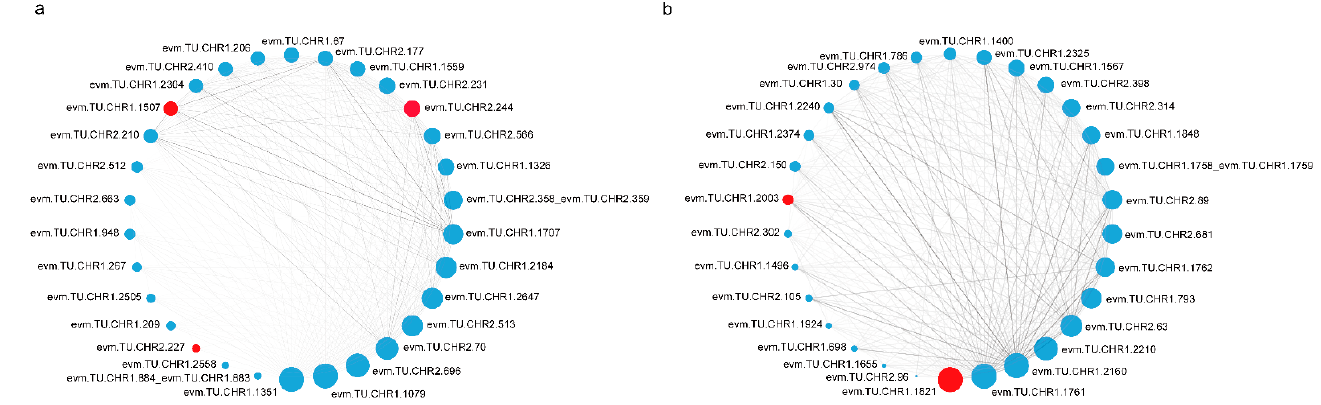
Figure 8. Co-expression regulatory network analysis of the black and blue module. Co-expression regulatory network analysis of the black and blue module. ( a ) Co-expression network constructed by 30 hub genes in black modules; ( b ) Co-expression network constructed by 30 hub genes in blue modules. Each circle represents a gene. The red circles represent transcription factors. The larger the circle, the higher the number of connections. The darker the black line connecting two nodes, the higher the edge weight value.